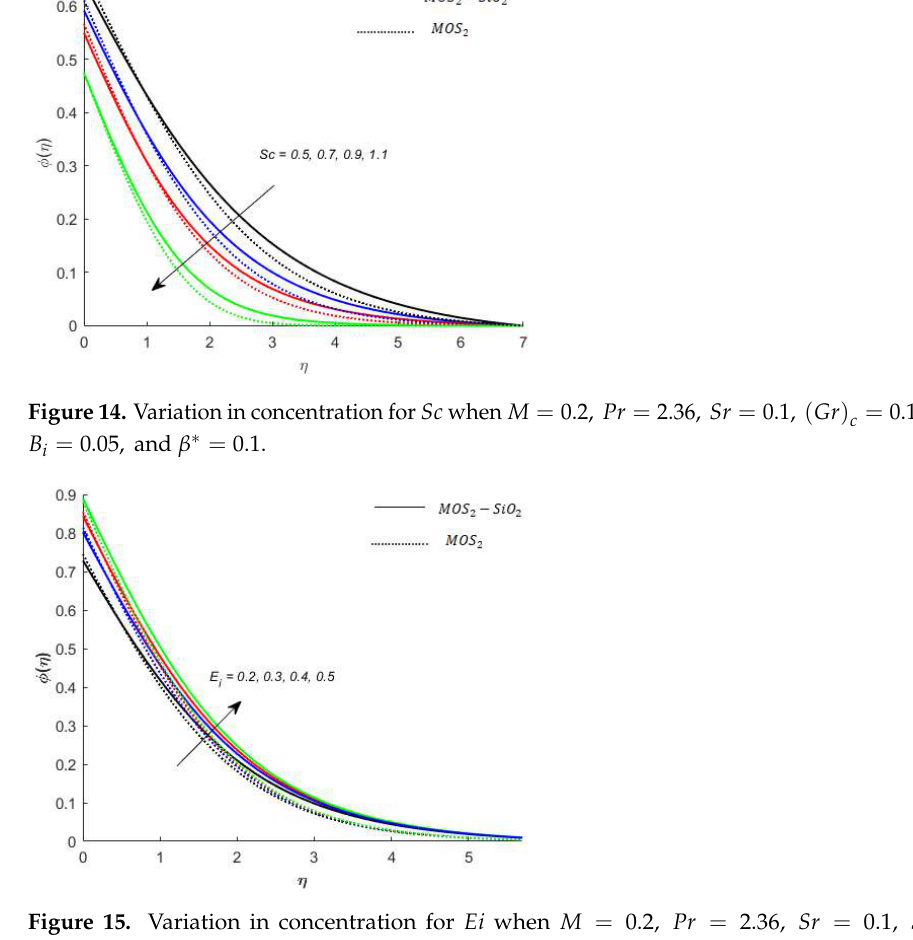
Figure 13. Variation in concentration for 𝑆𝑟 when 𝑀 = 0.3,𝑃𝑟 = 2.5,𝐸𝑐 = 0.3,𝑆𝑐 = 0.3, (𝐺𝑟) (cid:3030) = 0.1,𝐾 = 0.1,𝐵 (cid:3036) = 0.3,and 𝛽 ∗ = 0.5.